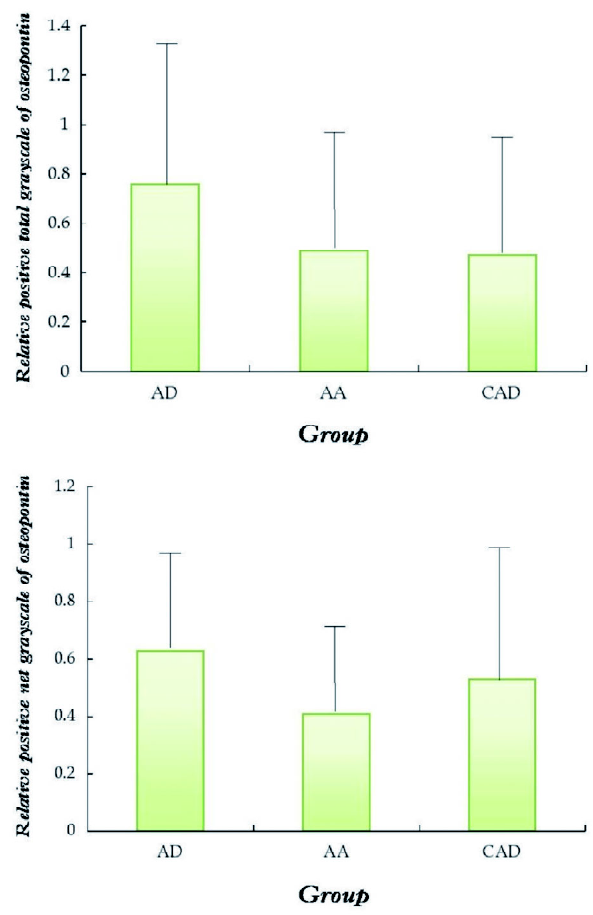
Fig. 4 - Relative grayscales of osteopontin by quantitative Western blot: (A) positive total grayscale: P = 0.229 for AD vs. AA, P = 0.948 for AD vs. CAD, and P = 0.240 for AA vs. CAD, and (B) positive net grayscale: P = 0.151 for AD vs. AA, P = 0.519 for AD vs. CAD, and P = 0.554 for AA vs. CAD. AA: aortic aneurysm; AD: aortic dissection; CAD: coronary artery